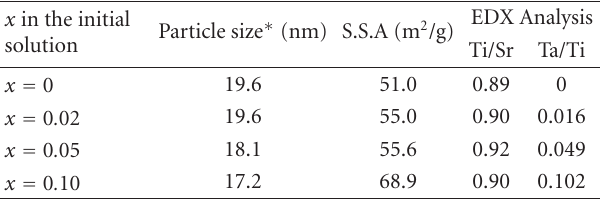
Table 1: Specific surface area, particle size, and Ti/Sr and